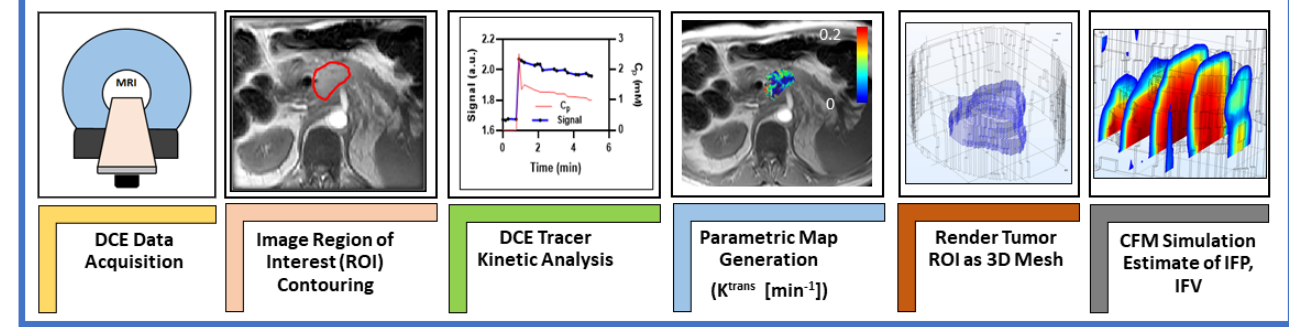
Figure 1. Representative workflow for MRI − based computational fluid modeling simulations.